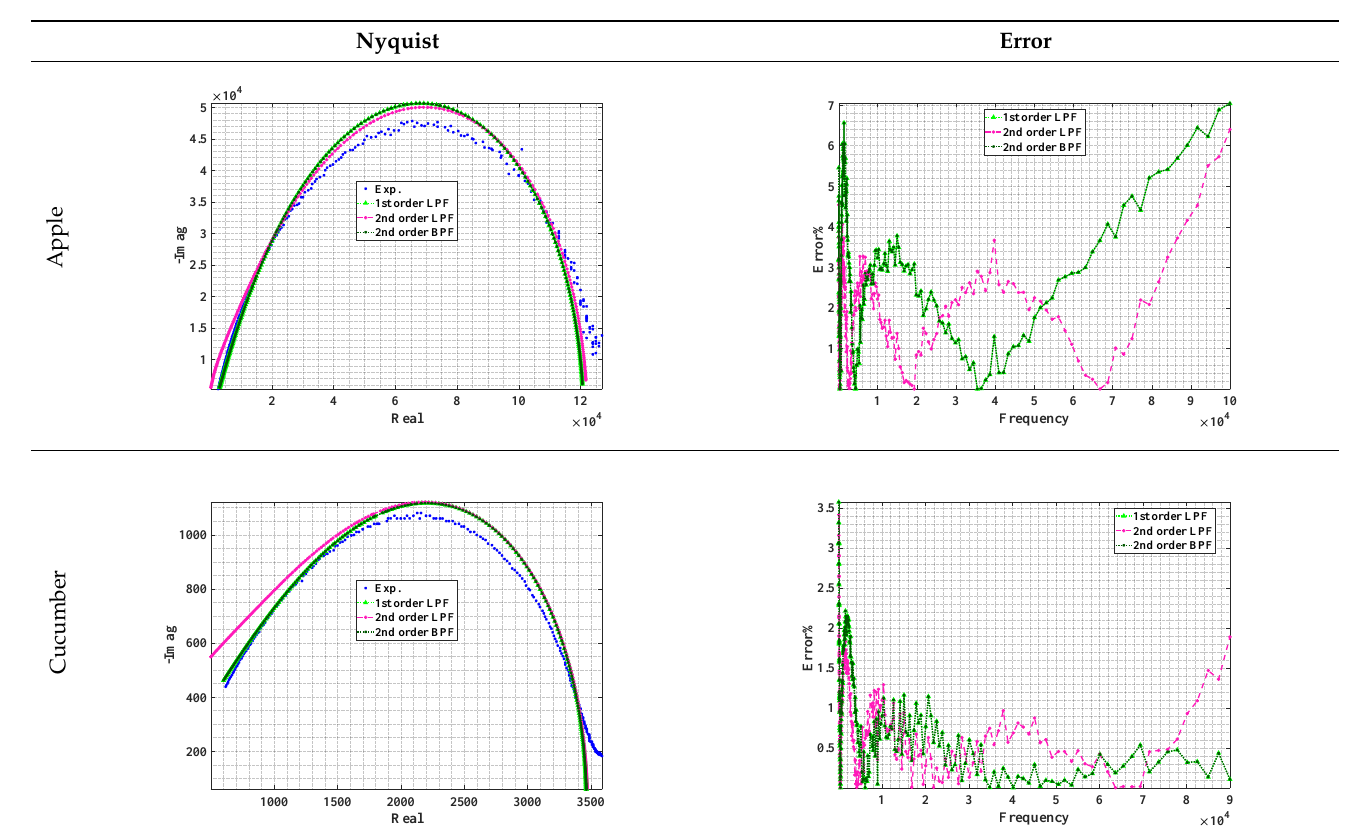
Table 2. Using WCA optimisation, the Nyquist and error plot of the experimental and the fitted single